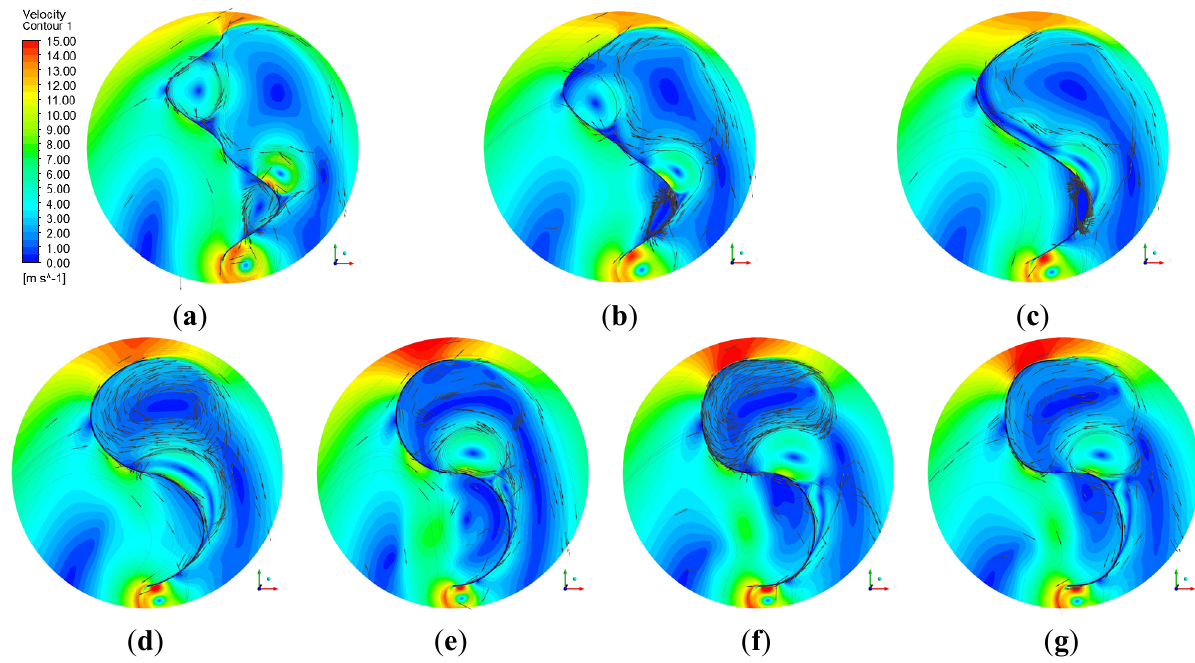
Figure 14. Velocity contours (m/s) and streamlines near the turbine for λ = 0.8 and θ = 270°. ( a ) n = 0.5; ( b ) n = 0.75; ( c ) n = 1.0; ( d ) n = 1.5; ( e ) n = 2.0; ( f ) n = 2.5 and ( g ) n =